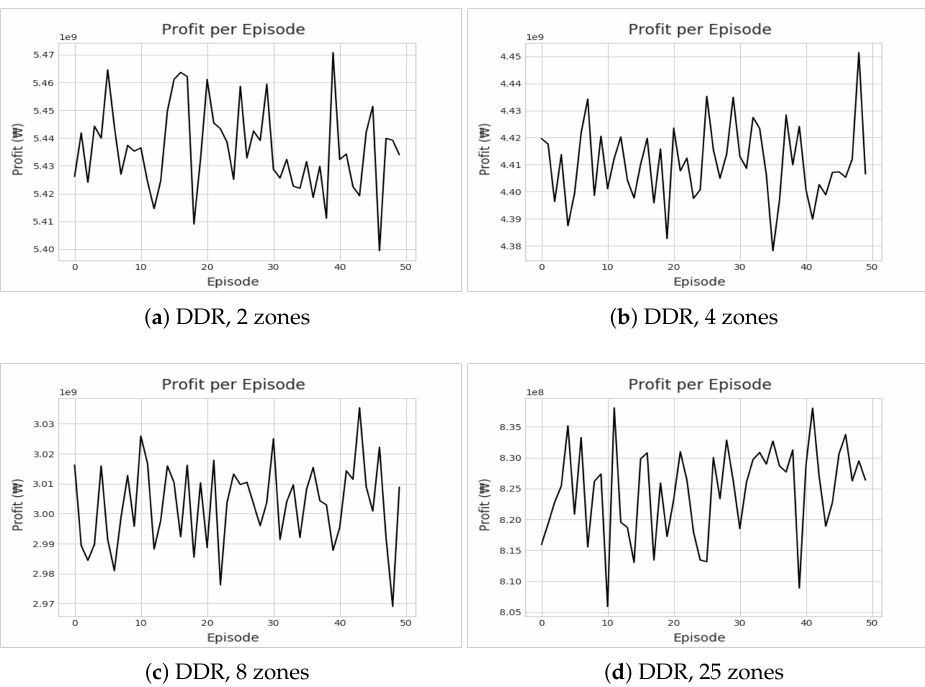
Figure 9. Illustrations of recorded cumulative profits by DDR for different zone